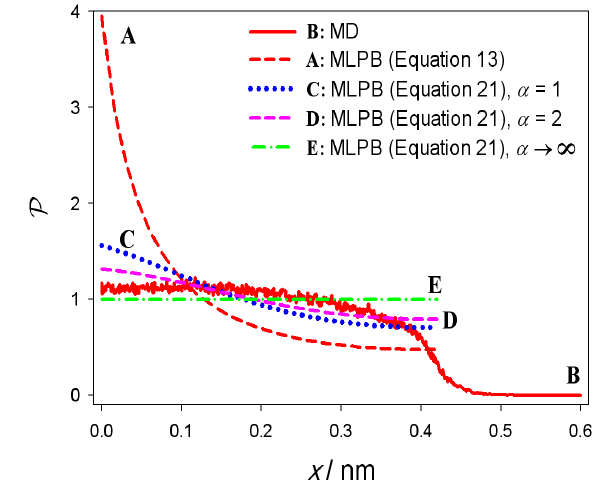
Figure 6. Probability density P ( x ) that the positive charge of the lipid dipolar headgroup (see also Figure 2) is located at the distance x from the negatively charged surface calculated from MLPB model (A,C,D,E) and obtained from MD simulations (B). The values of MLPB model parameters are the same as in Figure